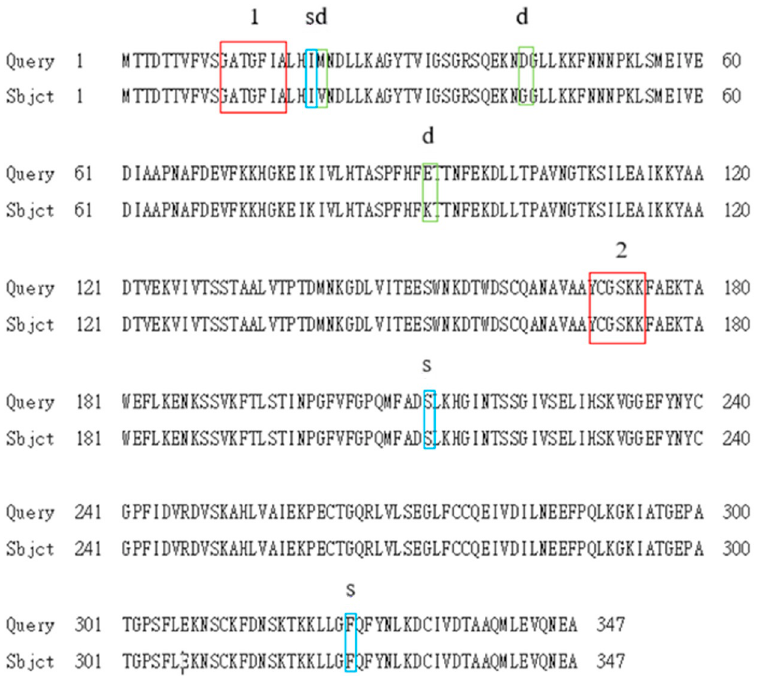
Figure 2. Comparison of the amino acid sequence for the ARI protein obtained in this study with that published by Liu et al., 2009. Query: The ARI amino acid sequence published by Liu et al., 2009. Subject: The ARI amino acid sequence in this study. 1 Cofactor binding site, 2 Active site, s DNA sequences were different from those of Liu et al. but their amino acids were the same. d Both DNA sequences and amino acids were different from those of Liu et al., 2009.